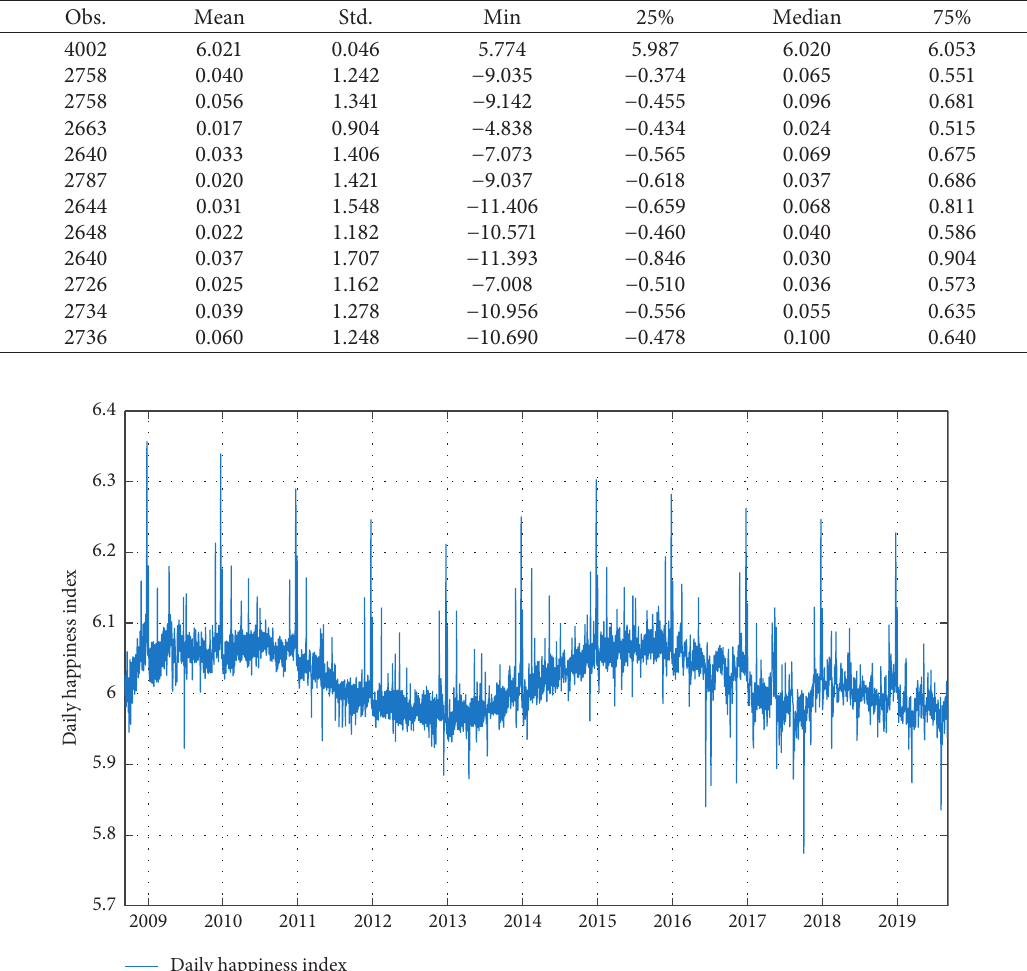
Figure 1: Evolution of daily happiness index during 2008–2019.